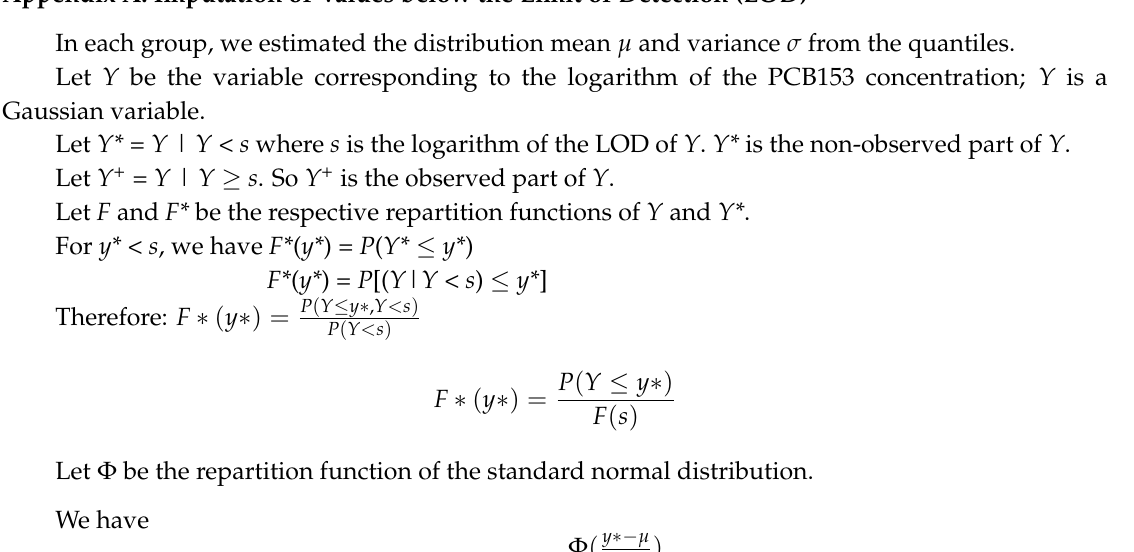
Figure S1: Temporal trend of environmental contamination levels reported as fractions of peak levels based on production data and estimated daily